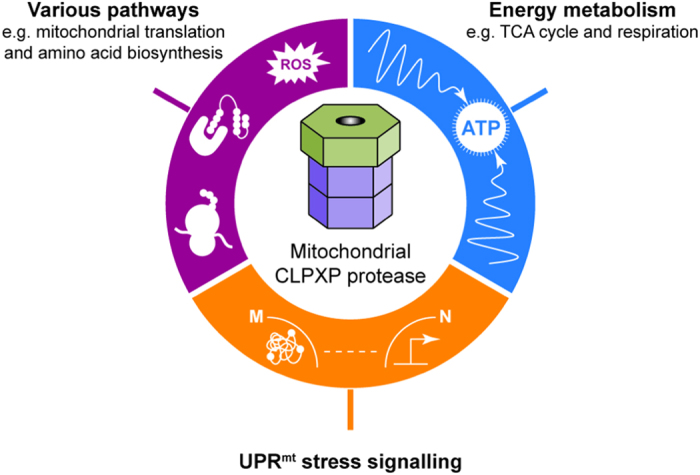
The different roles of mitochondrial CLPXP.The proteolytic component CLPP degrades misfolded mitochondrial proteins in C. elegans to initiate UPRmt stress signalling, which leads to the induction of nuclear-encoded mitochondrial protective genes15. Our study identifies specific proteins and pathways that are likely targets of CLPXP, suggesting a dedicated role of this protease in regulation and maintenance of mitochondrial energy metabolism. The observation that CLPP-knockdown in cancer cells impairs oxidative phosphorylation is in support of this emerging view17. Furthermore, several chaperones and components of other mitochondrial pathways, e.g. those controlling translation, redox homeostasis, and amino acid biosynthesis, were found as additional potential targets or interactors of CLPXP.